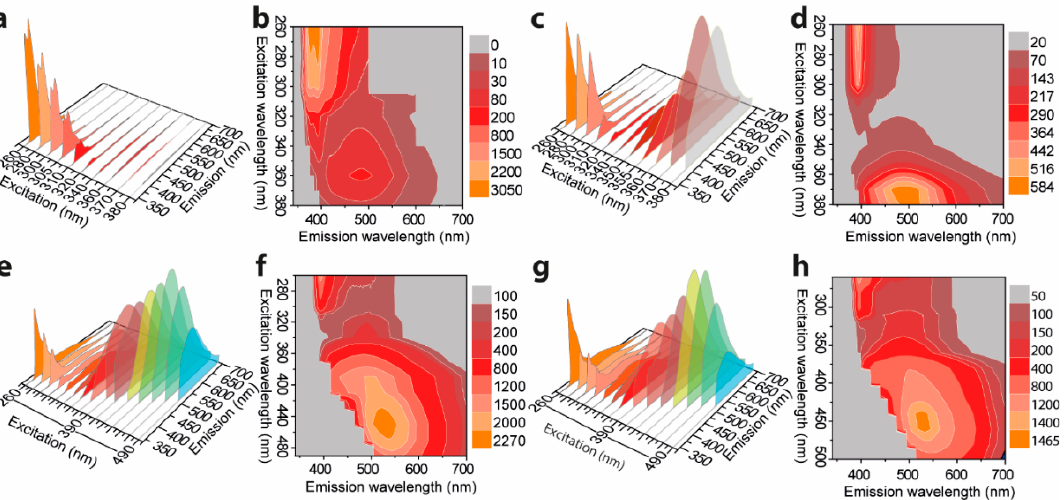
Figure 3. Excitation wavelength dependent three-dimension (3D) and two-dimension (2D) emission spectra of L-TPE: with ( a , b ) 1 mg/mL, ( c , d ) 2 mg/mL, ( e , f ) 5 mg/mL, and ( g , h ) 10 mg/mL of concentrations, respectively.